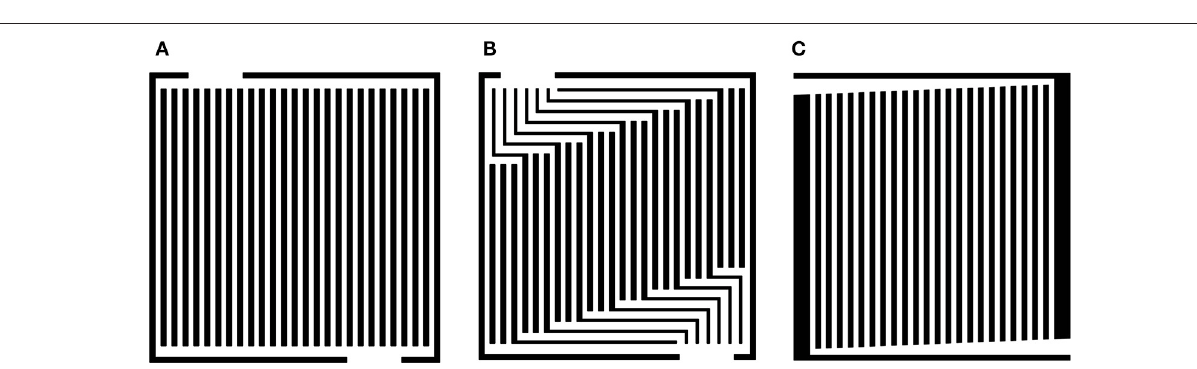
FIGURE 4 | Examples of modifications of the parallel design: one multi-path inlet/outlet (A) , several multi-paths (B) and inlets/outlets of a constant width with a gradually decreasing inlet channel (C)